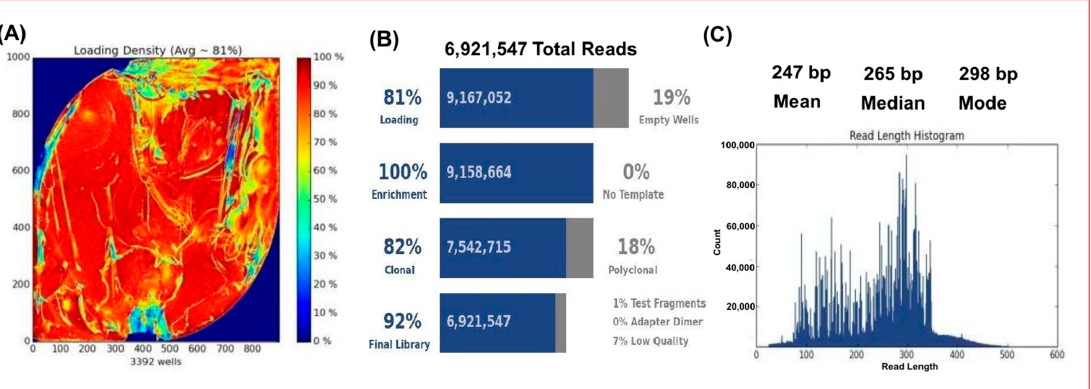
Figure 3. Analysis metrics for Ion Torrent Personal Genome Machine (PGM) amplicon sequencing for virulence genes present in a pool of 23 Salmonella strains. ( A ) Heatmap showing an optimal Ion Sphere Particle (ISP) density loading of 81% on the surface of PGM 318 chip. Red and blue colors represented the highest and lowest loading density areas, respectively. ( B ) A total of 6.9 million reads was obtained from the sequencing run and 82% reads were clonal. ( C ) Read length distribution of this representative run, with mean, median, mode length of 247 bp, 265 bp and 298 bp, respectively. Table 3. Number of virulence gene variants present in each of 29 Salmonella enterica strains identified with the correct serovar designation as a result of automated, real time mapping of sequence reads to preloaded reference genomes by the Ion Torrent sequencer.